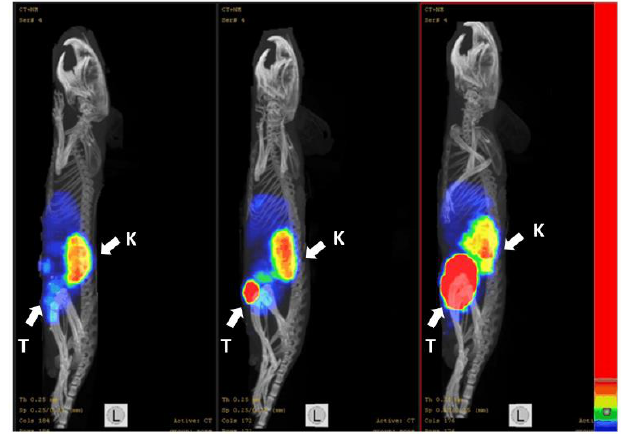
Figure 13. The SPECT-CT imaging using 99m Tc-ZHER2:41071 of mice with different tumor remission level after treatment with 188 Re-ZHER2:41071. Imaging was performed at day 35 after treatment start. The scale is linear showing arbitrary units normalized to a count rate in kidneys. The arrows with the letter “T” point to the tumors, and the arrows with the letter “K” point to the kidneys.